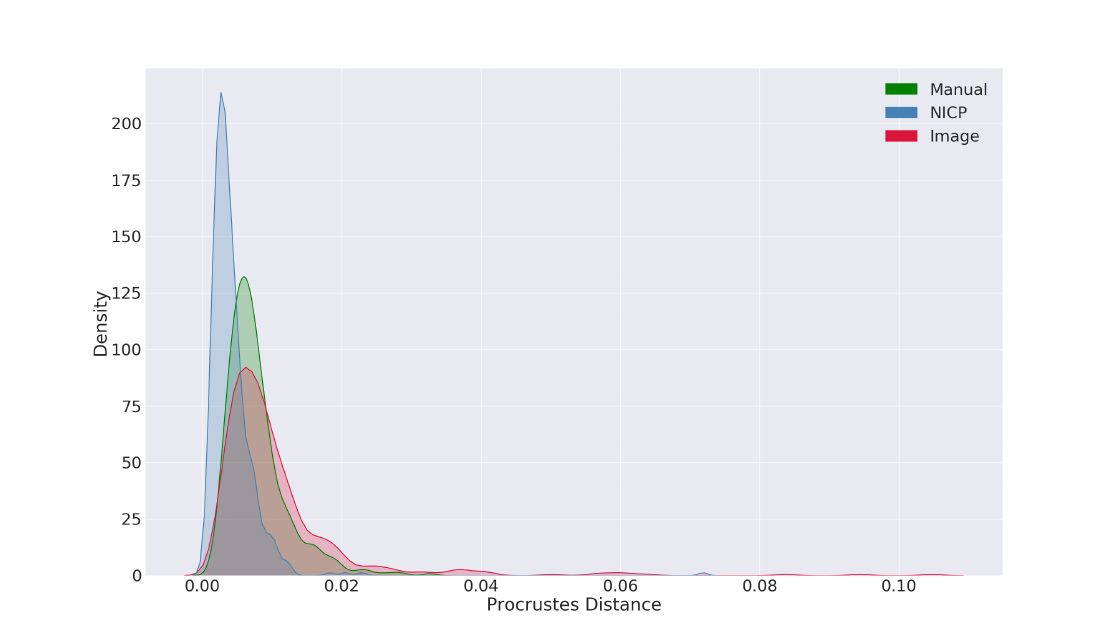
Figure 8. A kernel density plot of Procrustes distances from the mean for different landmarking